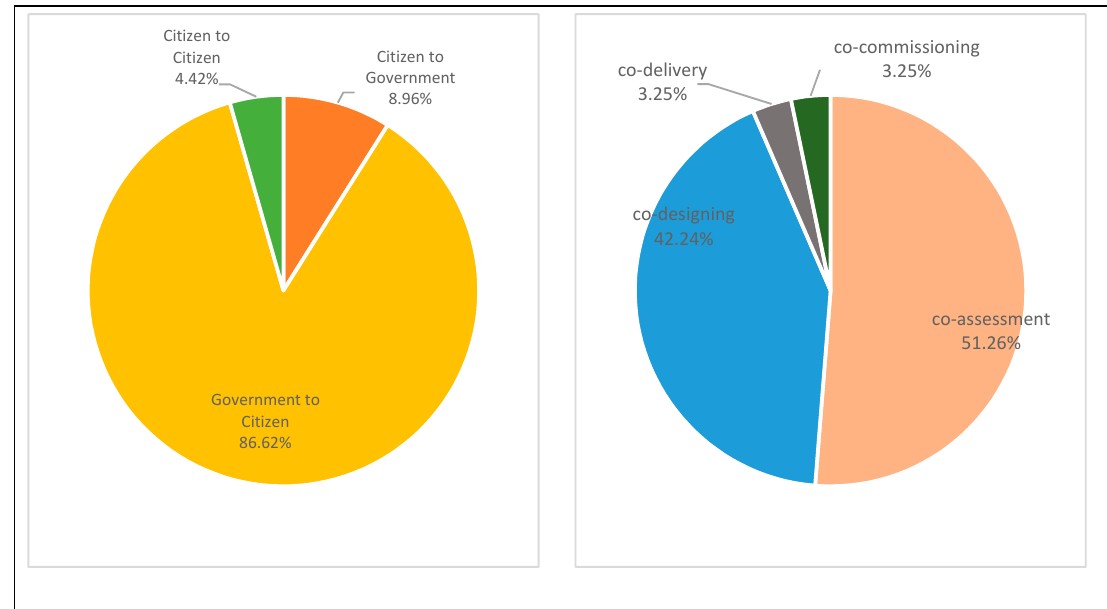
Figure 2. Social media interaction by coproducer and by service cycle.